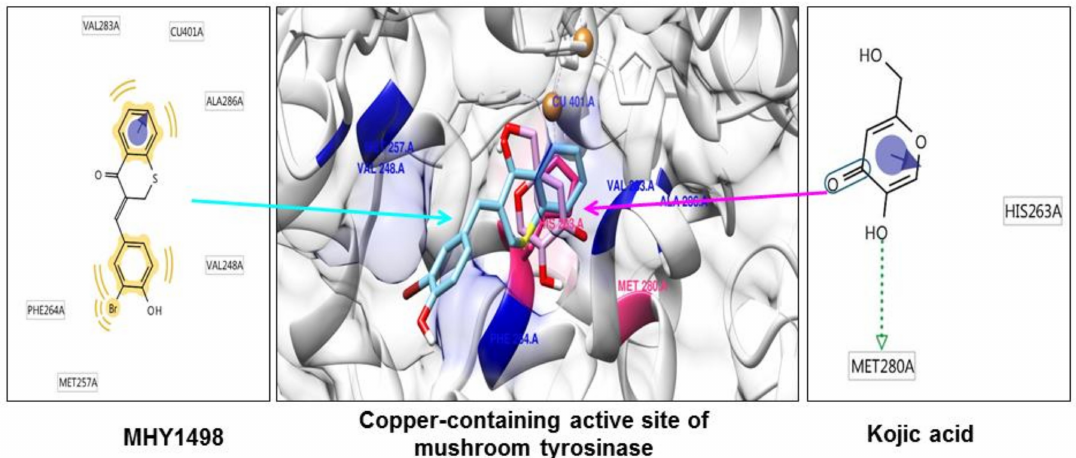
Figure 4. In silico docking simulation between MHY1498 or kojic acid and tyrosinase. The computational structure prediction for mushroom tyrosinase is shown in the middle, with MHY1498 bound close to the copper-containing tyrosinase active site. The two brown spheres indicate copper ions at the active site. Cyan denotes MHY1498 binding sites, and red indicates kojic acid binding sites. The binding residues of MHY1498 (left panel) and kojic acid (right panel) were analyzed using Autodock Vina, AutoDock 4, and Dock